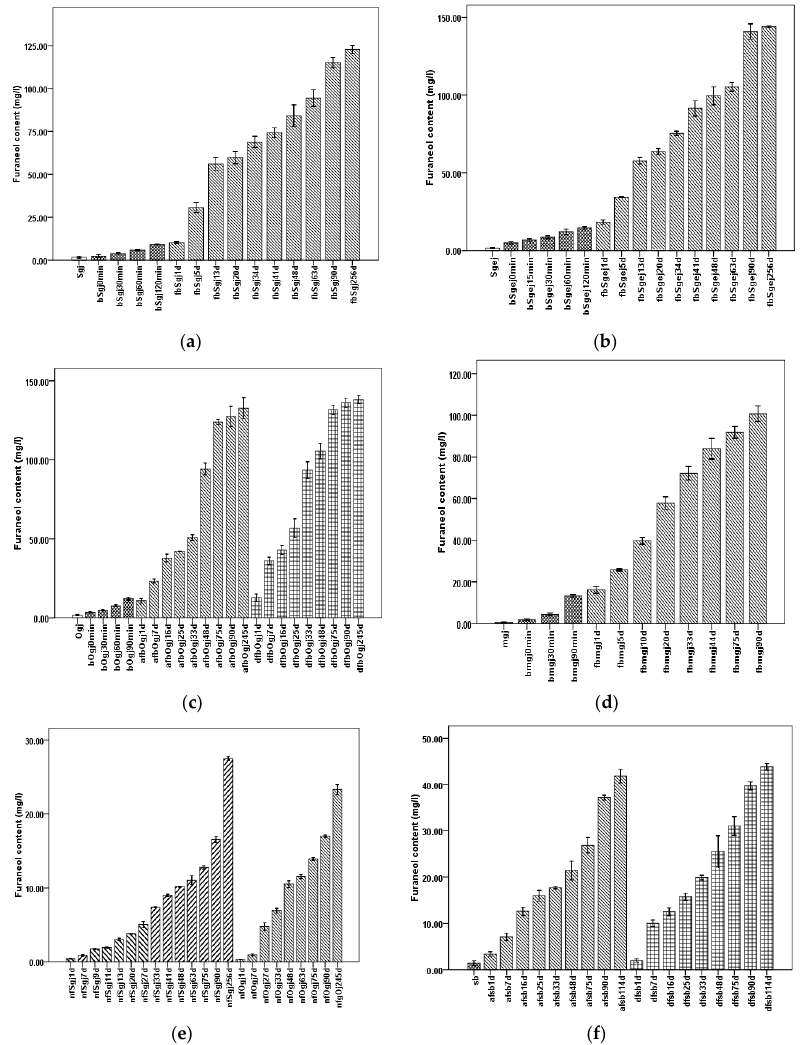
Figure 1. Changes of furaneol content during Msalais-making. The furaneol content was determined in six different models: ( a ) Sj1 model; ( b ) Sj2 model; ( c ) Oj model; ( d ) mj model; ( e ) sb model; and ( f )